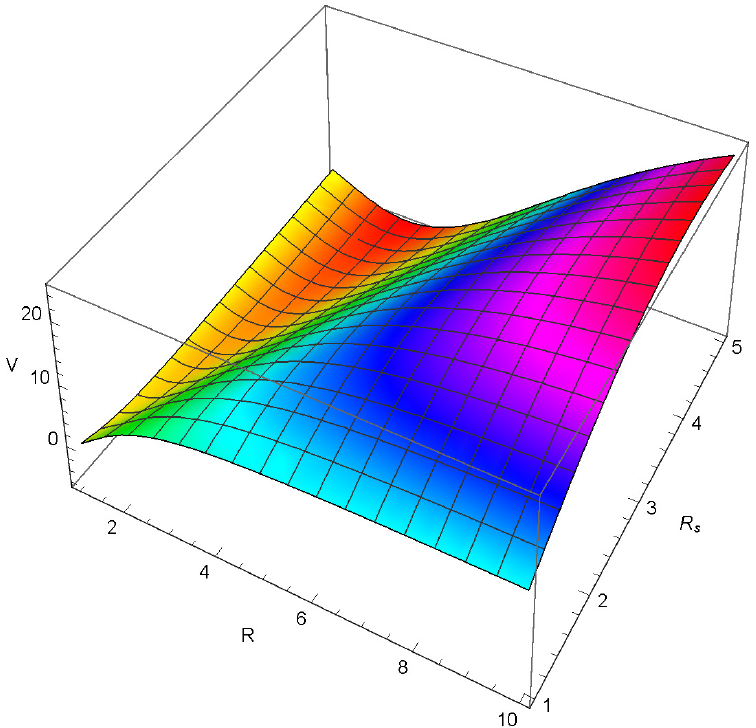
Figure 28. Solution of V ( φ 2 ) for n = 1. The evolution of V ( φ 2 ) is obtained using Equations (32) and